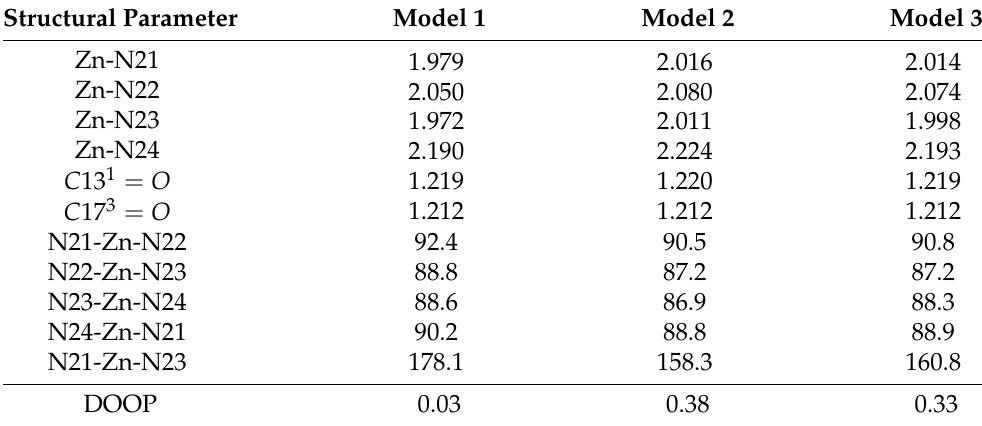
Table 1. Key bond lengths (in Å) and bond angles (in degrees) of model 1, model 2, and model 3.